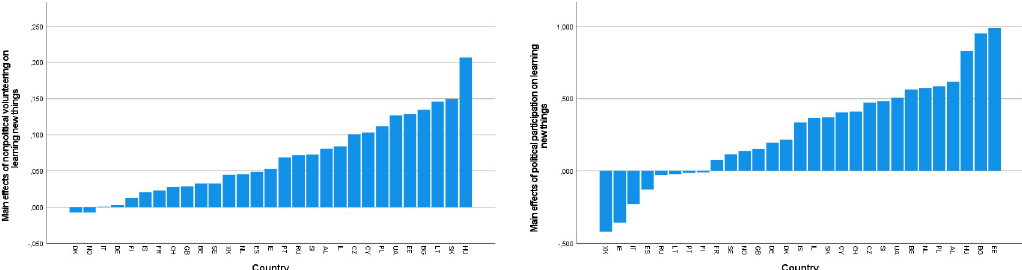
Fig 3. a. Country distribution of the main effects of nonpolitical volunteering on learning new things. b. Country distributions of the main effects of political participation on learning new things.